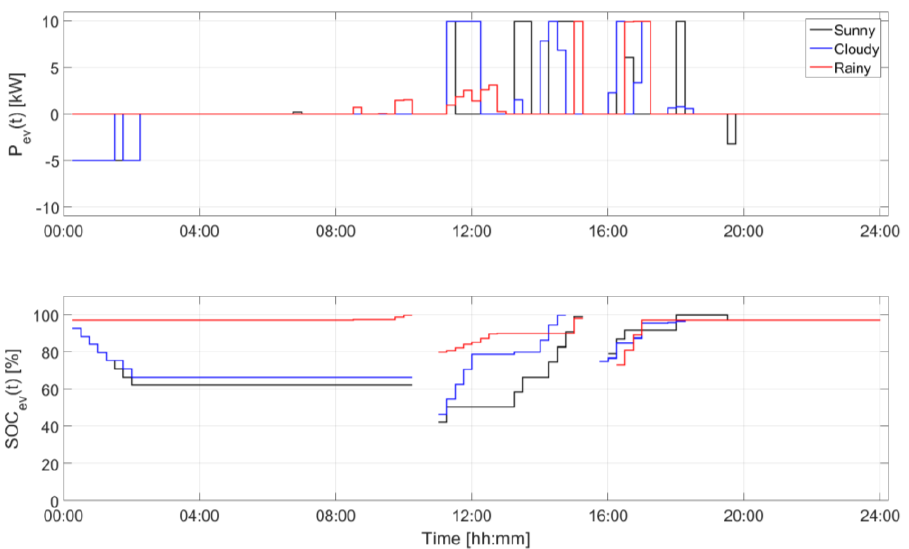
Figure 8. Power exchange between the test microgrid and EV 1 and the related SOC on the three days.